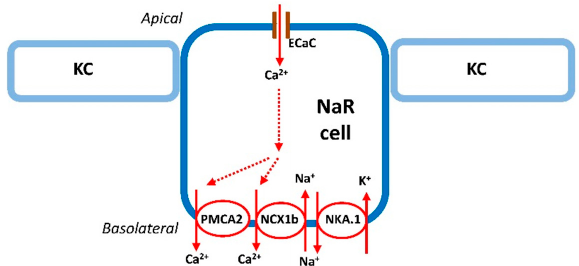
Figure 1. Na + -K + -ATPase-rich cell (NaRC) in zebrafish. Details of the transport pathways refer to the text (“The mechanism of Ca 2+ uptake in zebrafish” section). ECaC, epithelial Ca 2+ channel; KC, keratinocyte; NCX1b, Na + /Ca 2+ exchanger 1b; NAK.1, Na + -K + -ATPase α 1 subunit subtypes (atp1a1a.1); NaRC, Na + , K + -ATPase-rich cell; PMCA2, plasma membrane Ca 2+ -ATPase 2. Solid and dashed arrows, the route of Ca 2+ transport in